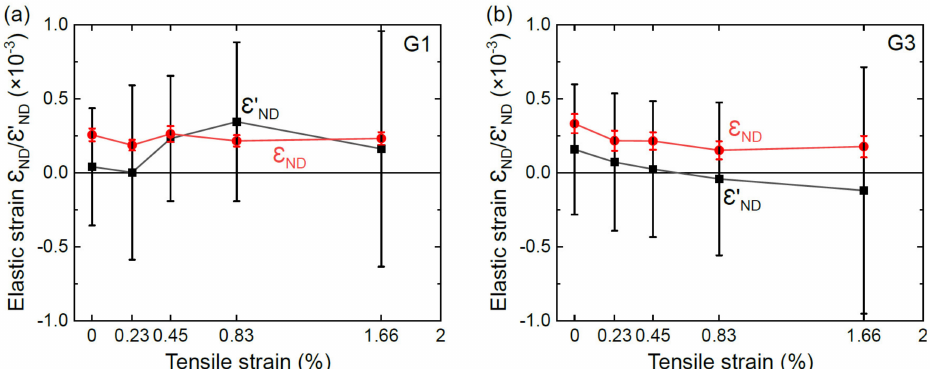
Figure 13. Average lattice strain ε ND and deviatoric strain ε (cid:48) ND (magnitudes larger than 2 × 10 − 3 are discarded during averaging) along two paths in two Al grains before and after tensile deformation to different strains. ( a ) In grain G1; ( b ) in grain G3. The error bars show standard deviations. The 0.2% offset yield point strain for Al is about